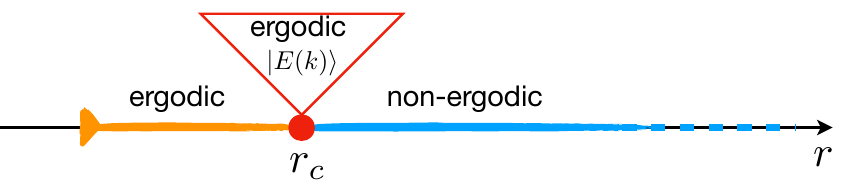
Figure 2. Phase diagram of the chaotic properties of the Schwarzian theory. The theory behaves thermally for the parameter range (cid:0)p 2 < r < r c with r c = p 2. The range r < r c corresponds to elliptic coherent state insertions, while the critical case r = r c can also be interpreted as the parabolic orbit corresponding to the eigenstates E ( k ) of the theory. In the full range (cid:0)p 2 < j i r r c we (cid:12)nd that the model scrambles with the maximal Lyapunov exponent predicted by ETH (cid:20) temperature, (cid:21) = 2 (cid:25)T ETH . In the hyperbolic range r > r c the Schwarzian theory behaves non- ergodically, and in particular its OTOC is oscillatory. See also table 8 for more